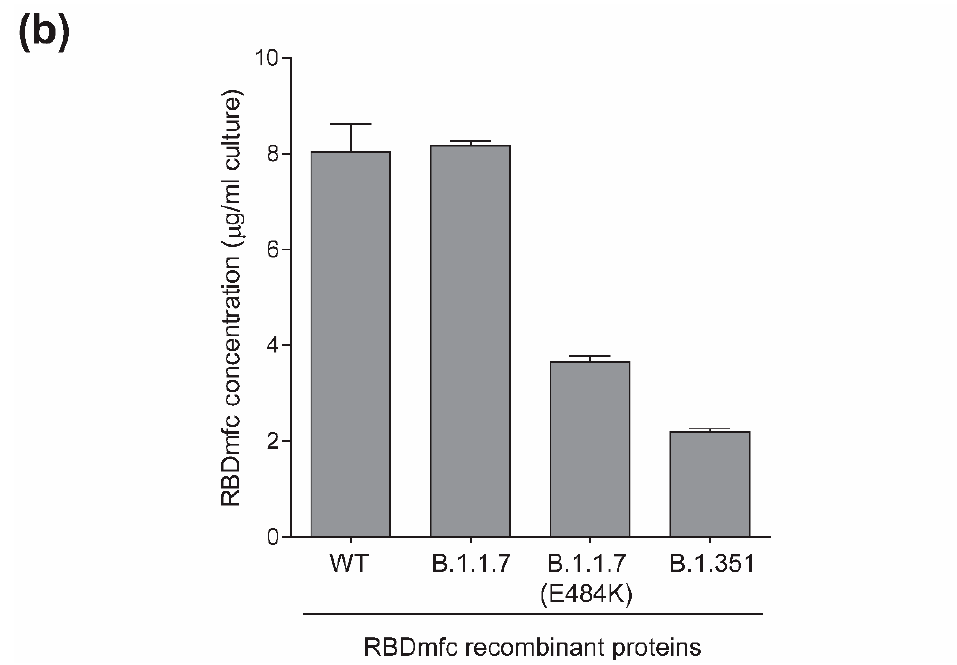
Figure 1. Expression of recombinant RBDmfc proteins in Expi293F cells. ( a ) Domain architecture of recombinant RBDmfc proteins investigated. The RBD domain (amino acids 331-524 of the spike protein) of SARS-CoV-2 isolate Wuhan-Hu-1 (wild type or WT) and variants B.1.1.7, B.1.1.7 (E484K) and B.1.351 was expressed by transient transfection into the Expi293F human cell line. RBD B.1.1.7 carries a single mutation (N501Y), RBD B.1.1.7 (E484K) two mutations (E484K and N501Y) and B.1.351 three mutations (K417N, E484K and N501Y) (shown in red). The respective RBD domains were expressed in fusion with an N-terminal optimised signal peptide to allow protein secretion and a C- terminal mouse IgG2a Fc fragment to facilitate purification on protein A affinity resin and to produce Y-shaped protein dimers. RBDmfc proteins are produced as dimers linked by disulphide bonds between their Fc fragments. One RBDmfc monomer is 437 amino acids long and has a predicted molecular weight of 49.2 kDa (upon cleavage of the signal peptide). ( b ) Concentration of RBDmfc proteins secreted in the culture medium of Expi293F cells, measured by Octet RED96 and expressed in µ g/mL culture. Values are mean (standard deviation) of two independent experiments. RBD mutants carrying the E484K mutation were expressed at lower levels in the medium of Expi293F cells. The level of secreted B.1.351 RBDmfc was 27% that of WT RBDmfc. By contrast, mutation N501Y